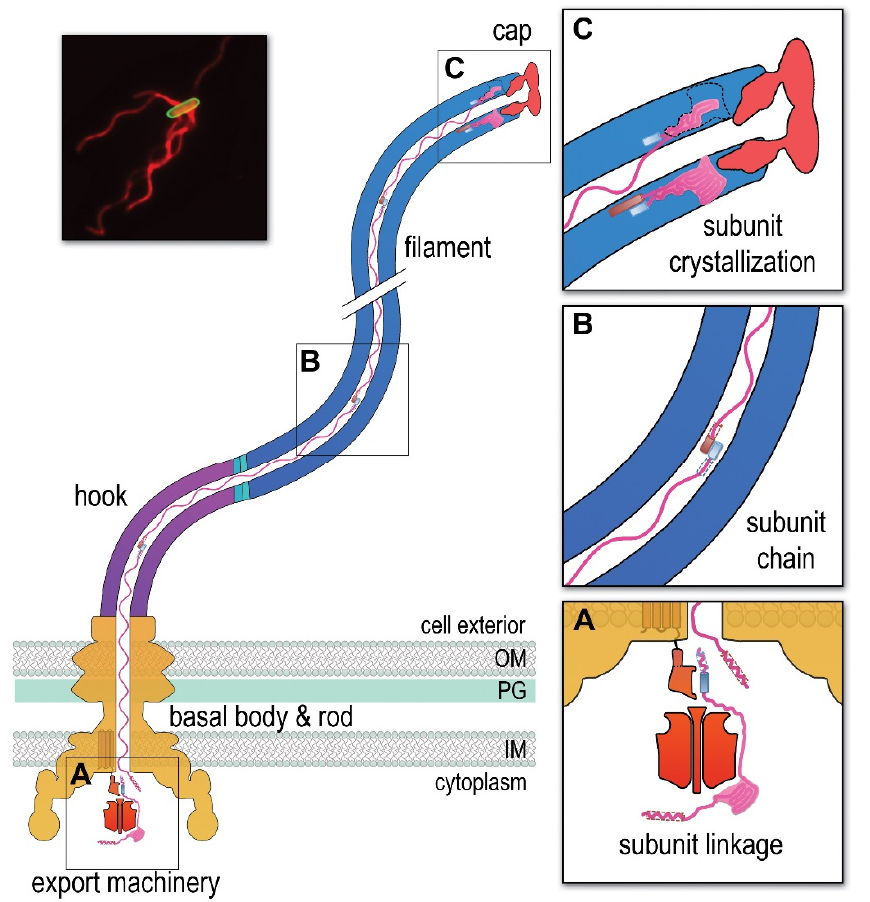
FIGURE 1: A chain mechanism for bacterial flagellum growth. Flagella on the surface of the bacterial cell (inset top right, Salmonella cell membrane stained green and flagella stained red, visualized by epifluorescence micros- copy) comprise three contiguous sub- structures - the basal body, hook and filament - that are assembled sequen- tially. A central channel runs through these substructures to the flagellum tip. The basal body houses the flagellar export machinery (A) and the rod (FliE, FlgB, FlgC, FlgF and FlgG), which ex- tends from the inner membrane (IM) and crosses the periplasm, peptidogly- can (PG) cell wall and outer membrane (OM). The cell surface hook (FlgE) is a flexible universal joint that connects the external flagellum filament (flagel- lin, FliC) to the basal body. (A) Subu- nits of the rod, hook and filament link head-to-tail at the cytoplasmic mem- brane export machinery. Subunits are first unfolded by the export ATPase complex (red) and then dock at the FlhB export gate (orange). The N- terminal helix of the docked subunit is then captured by the free C-terminal helix of an exiting subunit in the flagel- lum channel. (B) Sequential subunits are linked head-to-tail in a chain by juxtaposed terminal helices forming parallel coiled-coils. The resulting chain of unfolded subunits is connect- ed through the flagellum central